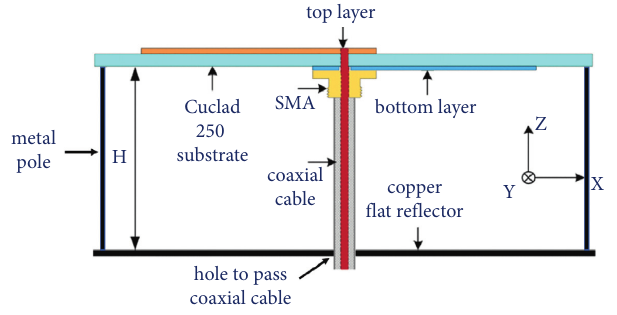
Figure 4: UCPCA side